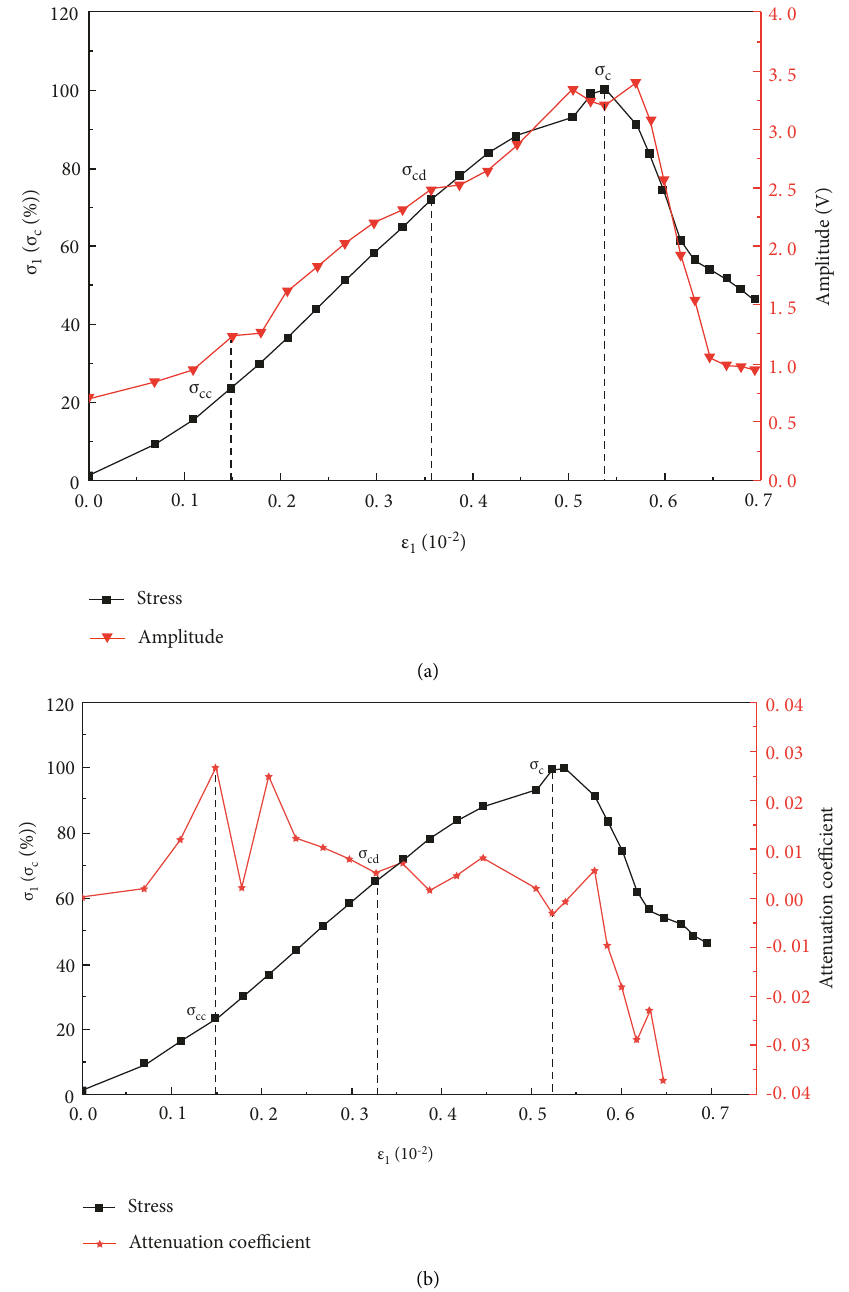
Figure 9: Relational curve between ultrasonic receiving amplitude. (a) Attenuation coefficient (b) of concrete sample and stress